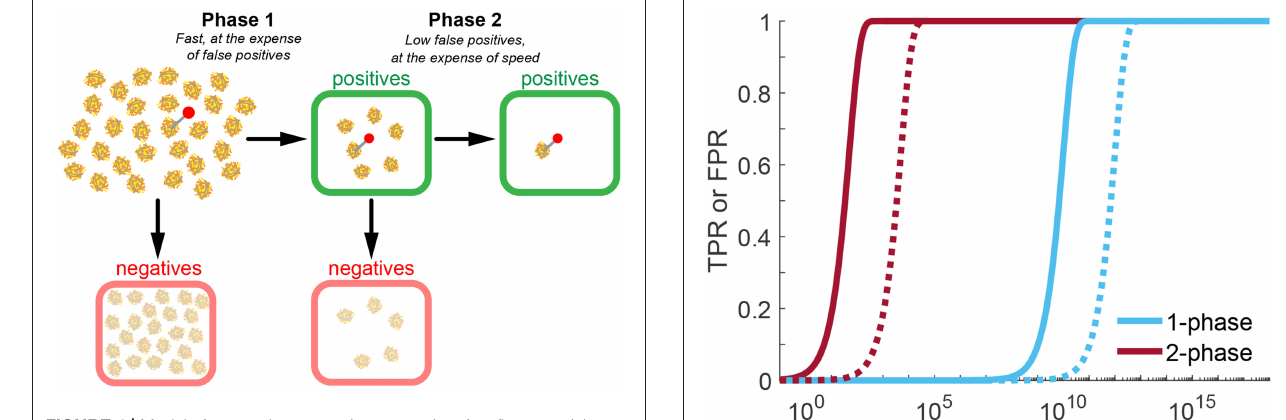
FIGURE 4 | Model of a two-phase search strategy. In a fast first scan (phase 1), candidate haybales are classified as positives (green boxes) or negatives (red boxes). Negatives are discarded and positives are re-evaluated in phase 2. Note the substantial number of false positives after phase 1. However, since much fewer candidates have to be scanned during phase 2, it is possible to conduct a more precise yet still time-efficient scan in phase 2.